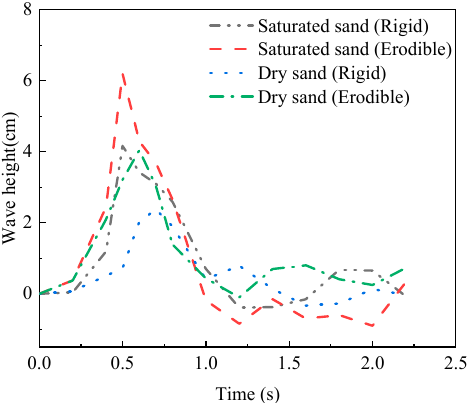
Figure 18. Temporal evolution of wave heights generated by granular landslides at the observation point (X = 0 m) under different conditions.